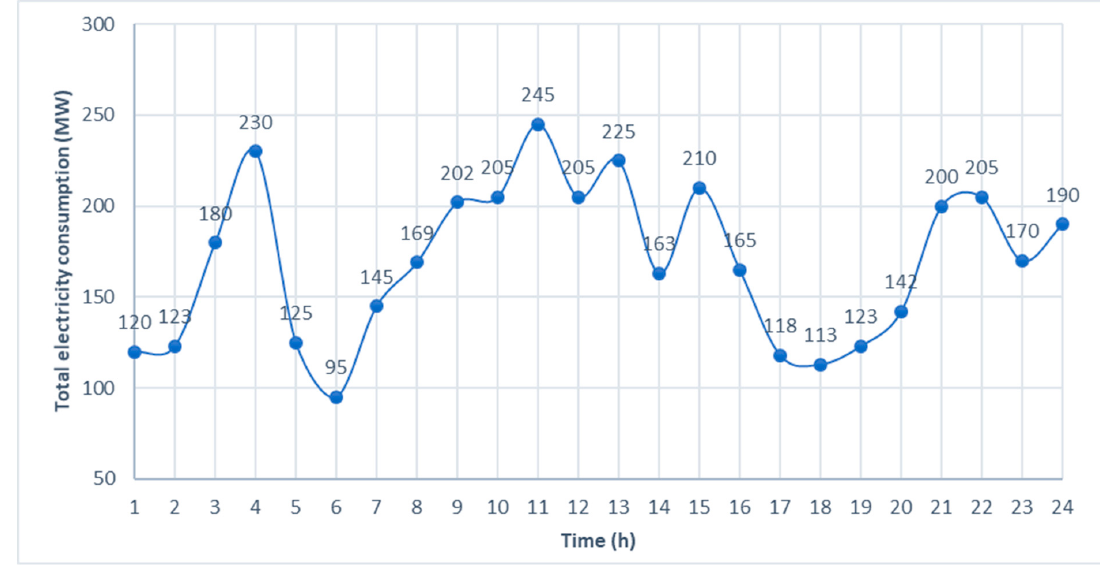
Figure 4. Total electricity consumption for the four industrial plants.